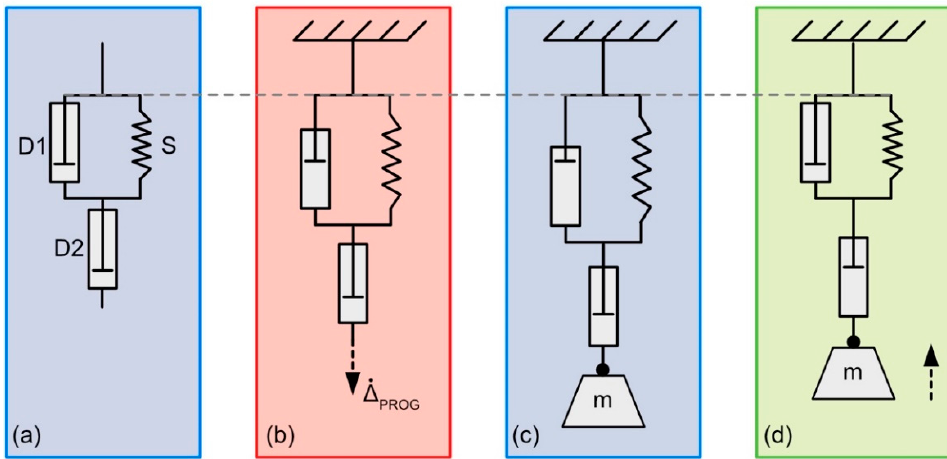
Figure 8. Schematic illustration of Lethersich [48] model. Temperature and chemistry color coding as introduced in Figure 1. ( a ) Model elements S , D 1, and D 2. ( b ) Programming. Application of a constant strain rate ∆(cid:4662) (cid:2900)(cid:2902)(cid:2899)(cid:2891) in mechanical test rig (experiment: Figure 3b). ( c ) State after programming and prior to chemical exposure (experiment: Figure 3c). ( d ) Chemically triggered actuation (experiment: Figure 6b).